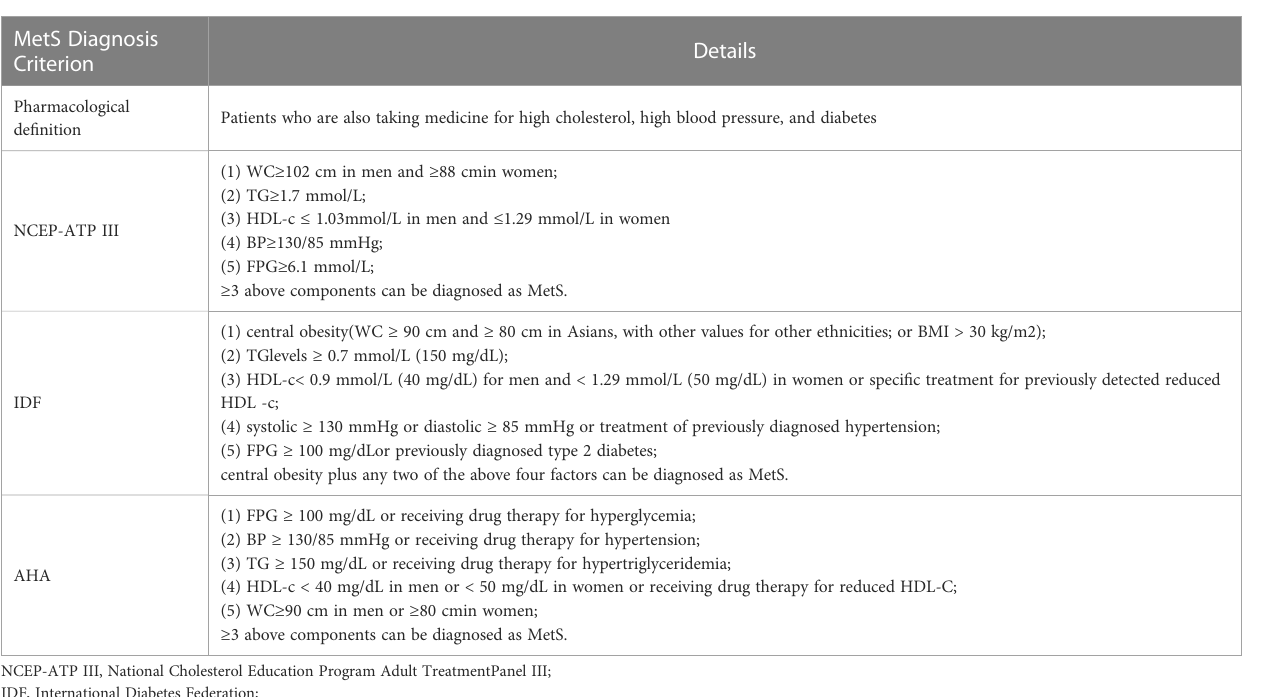
TABLE 3 Different Criteria for MetS